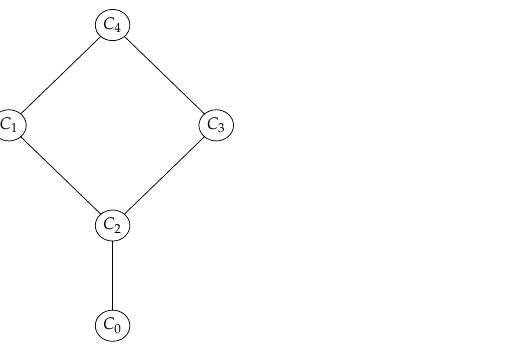
Figure 2. Concept lattice for the one-sided formal context of Example